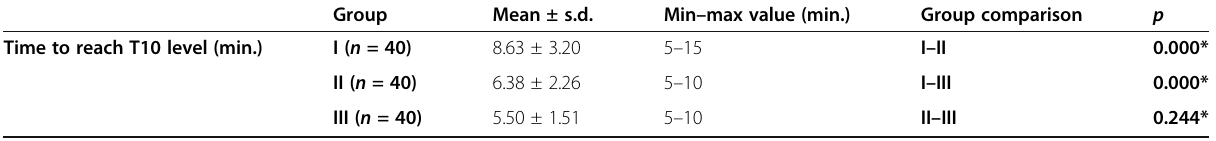
Table 2 Time to reach the T10 level for each group (min) Group Mean ± s.d. Min – max value (min.) Group comparison p Time to reach T10 level